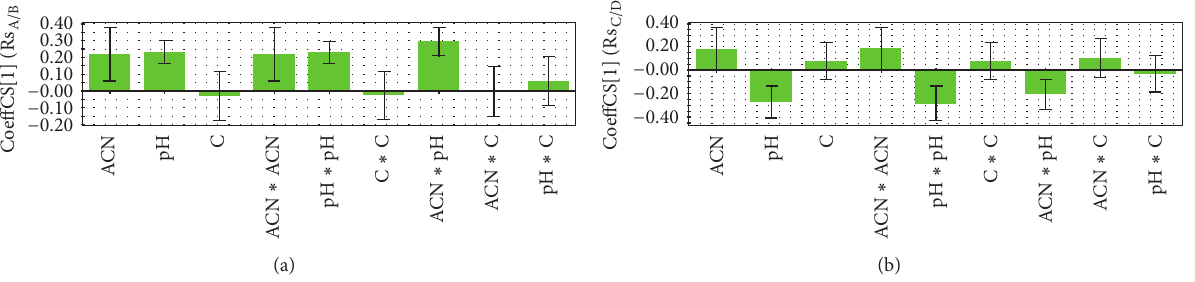
impurities C and D (corresponding to 0.024%) and of LOQ 0.04 𝜇 g/mL for impurities A and B (corresponding to 0.04%) and 0.08 𝜇 g/mL for